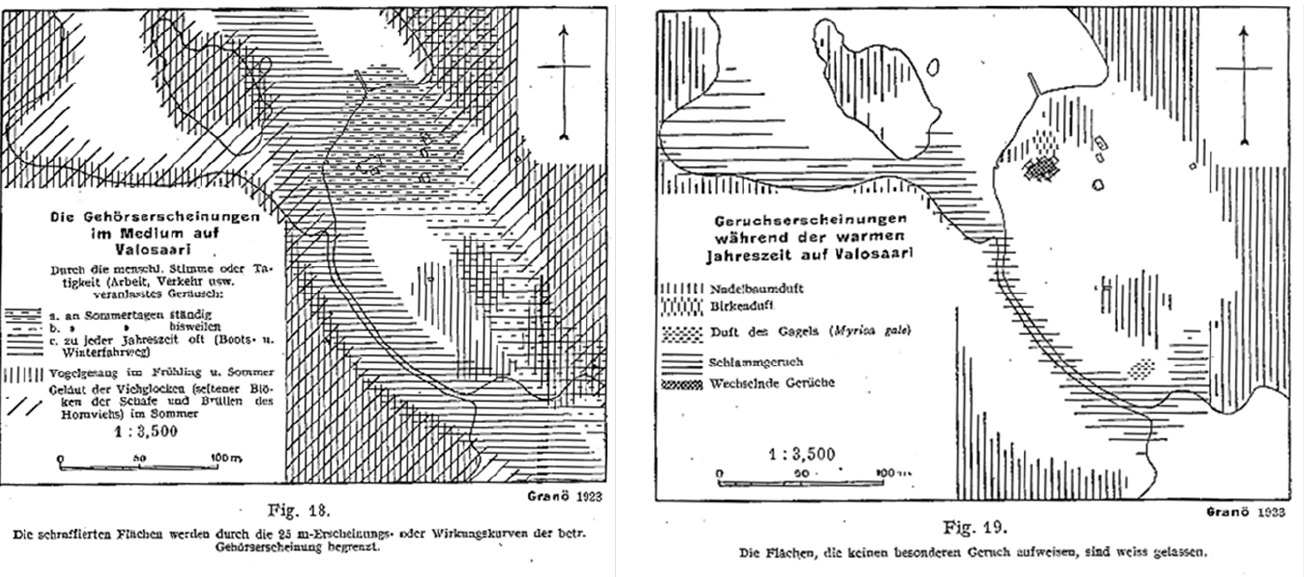
Figure 3: Mapping examples of the Finnish Valosaari Island concerningauditory (left) and olfactory phenomena (right) (Granö,